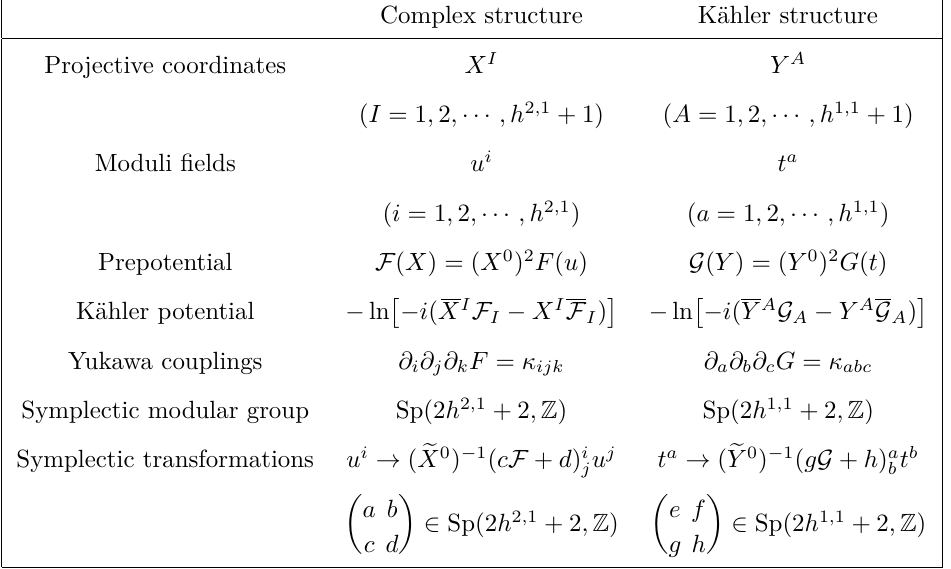
Table 1 . Moduli spaces of the complex structure and the Kähler